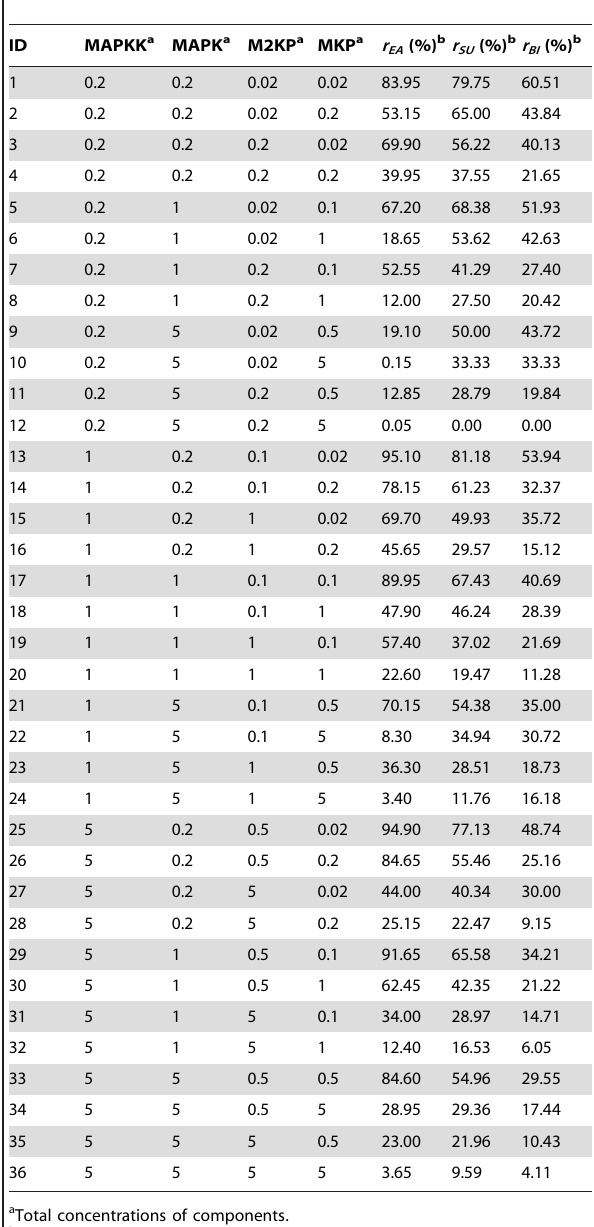
Table 2. Concentration vectors and statistics of MAPK